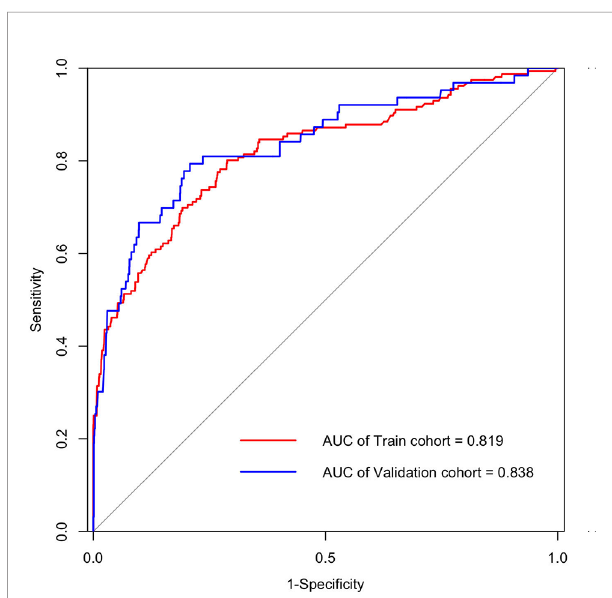
FIGURE 3 | ROC curves of the nomogram for predicting SARS-CoV-2 breakthrough infection among vaccinated individuals in training cohort (AUC, 0.819; 95% CI, 0.780 – 0.858; sensitivity, 0.712; and speci fi city, 0.801 at the optimal cutoff of 0.027) and validation cohort (AUC, 0.838; 95% CI, 0.778 – 0.897; sensitivity, 0.792; and speci fi city, 0.794 at the optimal cutoff of 0.041). AUC, the area under the receiver operating characteristic (ROC) curve.